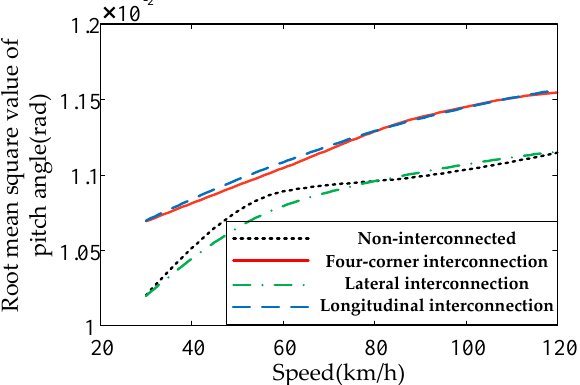
Energies 2019 , 12 , x FOR PEER REVIEW Figure 9. RMS value of pitch angle under the straight condition. Figure 9. RMS value of pitch angle under the straight condition. Figure 9. RMS value of pitch angle under the straight condition.